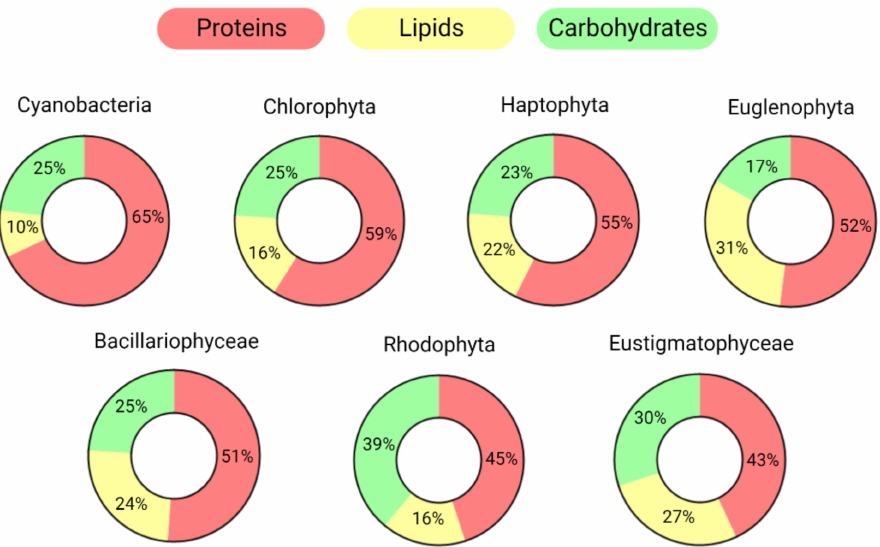
Figure 1. Average macromolecular compositions of the main microalgal taxonomic groups. Groups are ordered based on their protein abundance. Only the three main pools are reported: proteins, lipids, and carbohydrates. The values are normalized, excluding other main components of the dry weight such as ash, moisture, and